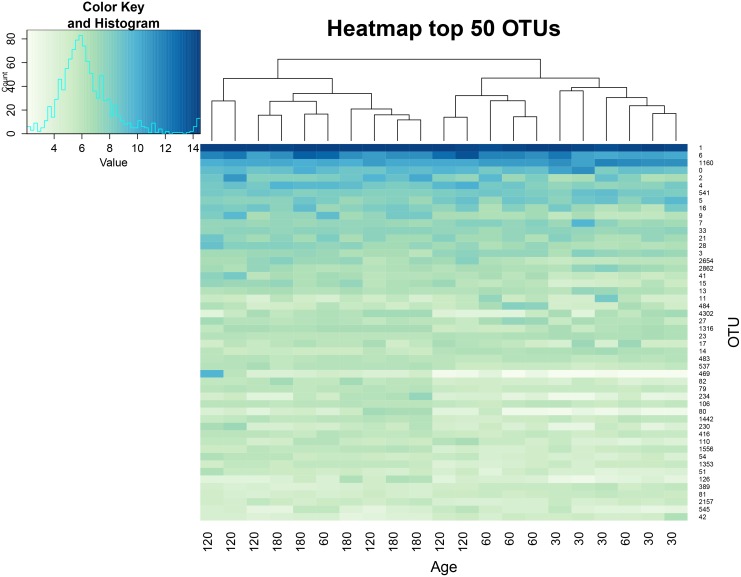
Assessment of differentially expressed ACS genes in samples across all age groups in heat map format.A heat map showing the rlog transformed expression data of the first 50 ACS amino acid sequences in the top ranked ACS sequences detected in the cecum of rabbits of different ages. The color scale ranges from blue (high expression) to white (low expression).